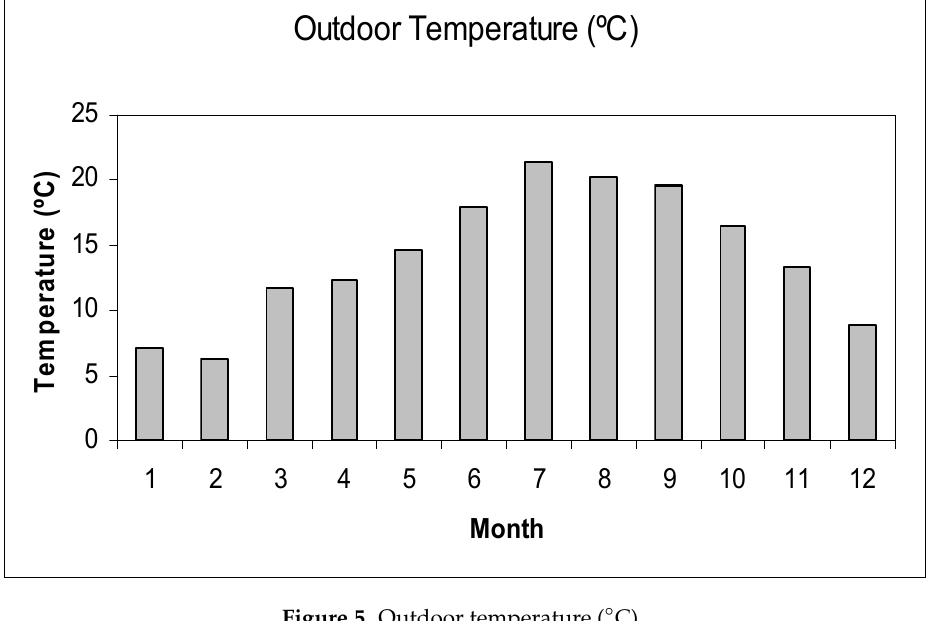
Figure 5. Outdoor temperature ( ◦ C).